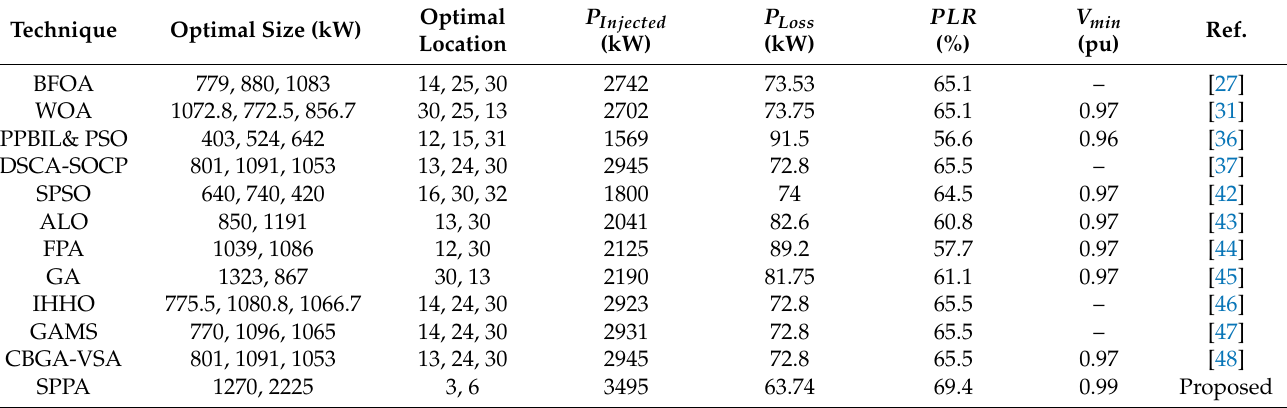
Table 1. Comparison and performance analysis of NW-1.